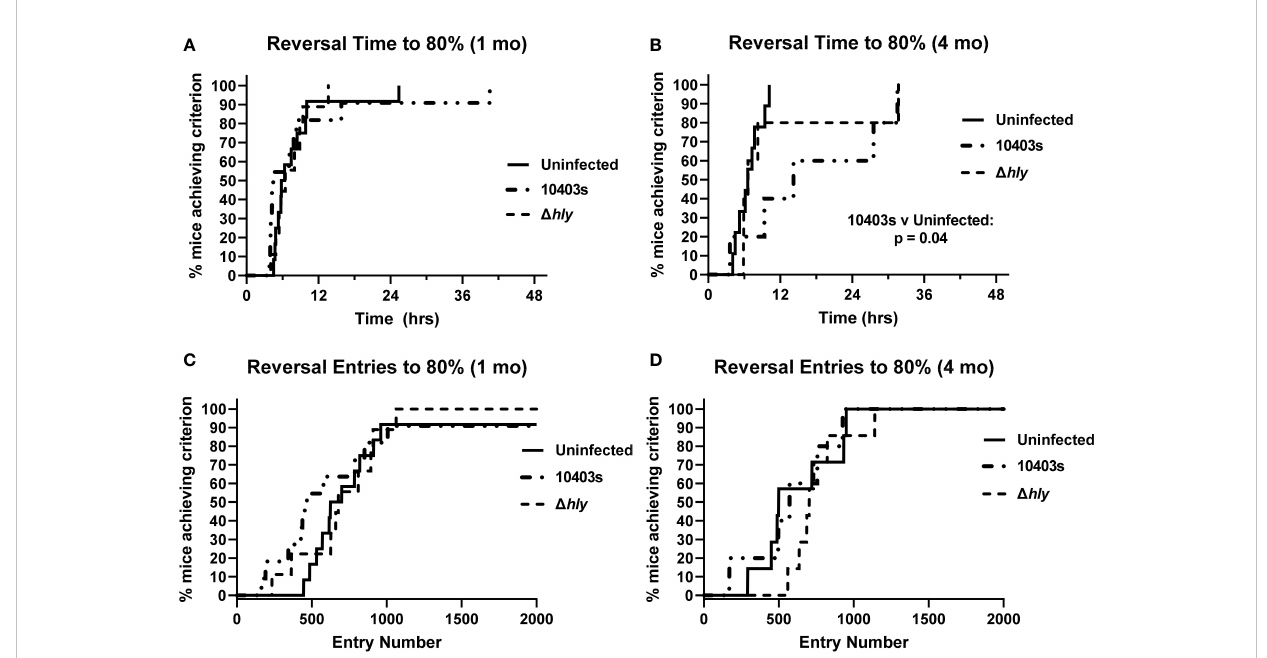
FIGURE 3 Infection with virulent Lm prolongs time to achieve criterion during reversal phase. Percent correct entries during the trailing 30 trials were calculated and the time or entries necessary to reach an 80% success rate calculated. Panels show the time (hrs) required (A, B) , and total number of entries (C, D) required versus the % of Uninfected (thin line), D hly Lm -infected (dashed line), and 10403s-infected (dotted line) mice. All panels display achievement of criteria within the reversal phase. Signi fi cance of Kaplan-Meier plots were calculated using a pairwise application of the log- rank test and signi fi cant differences are